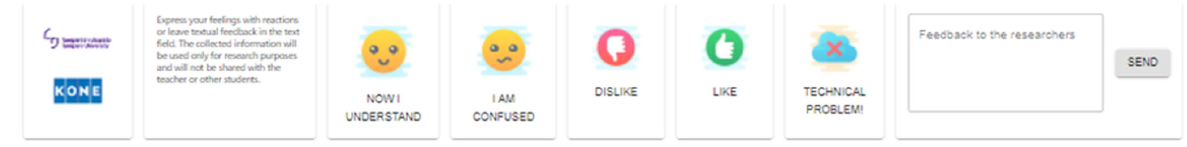
Figure 4. The “Research Panel” tool for learners to collect reactions during the remote training